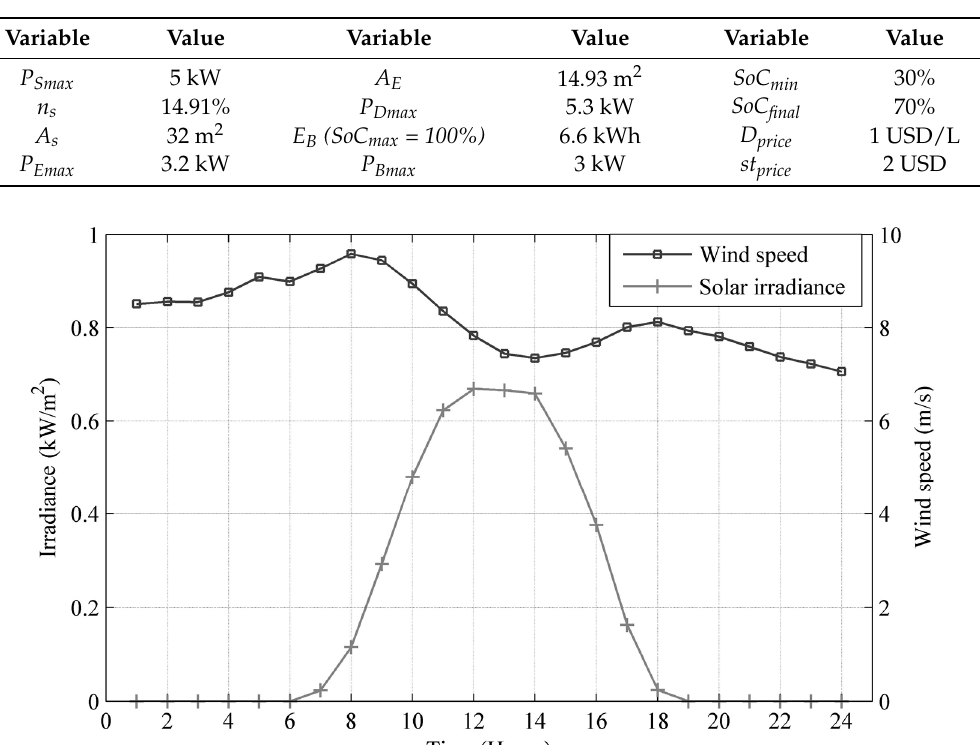
Table 1. Parameters of the microgrid in Taroa.